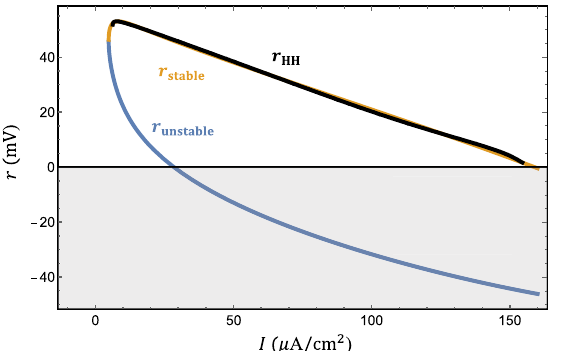
Figure 7. Fitting the firing amplitude of the Hodgkin-Huxley neuron. The firing amplitude of the effective U(1) neuron (orange) fits that of the Hodgkin-Huxley neuron (black) rather well. The firing amplitude of the unstable limit cycle (light blue) is also shown for